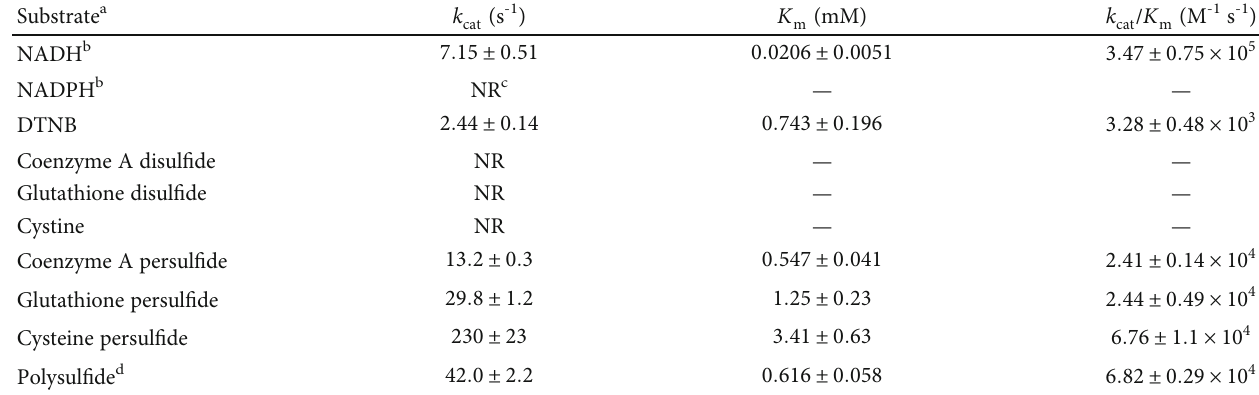
Table 2: Steady-state kinetics of AfNpsr under aerobic conditions at 70 °